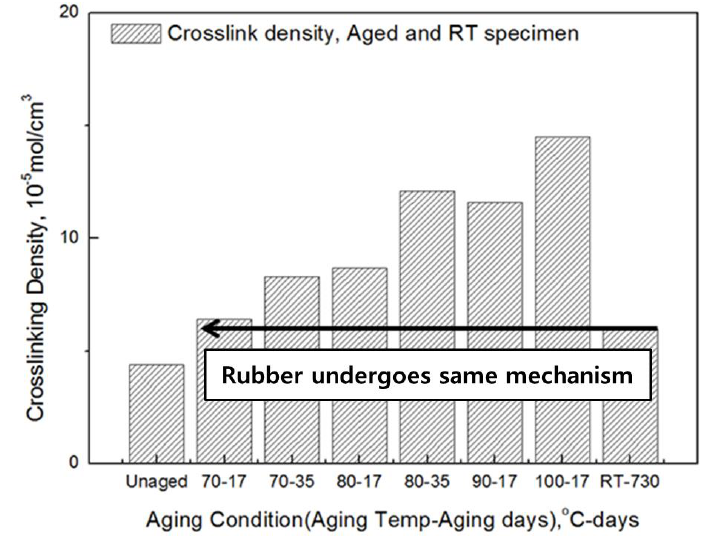
Figure 3. Comparison of crosslink density between aged and RT specimens.